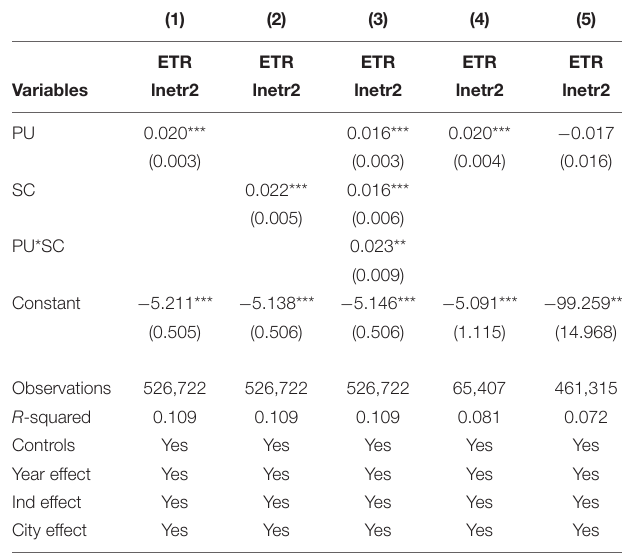
TABLE 6 | Results of regression analysis after IHS transformation for the ETR.